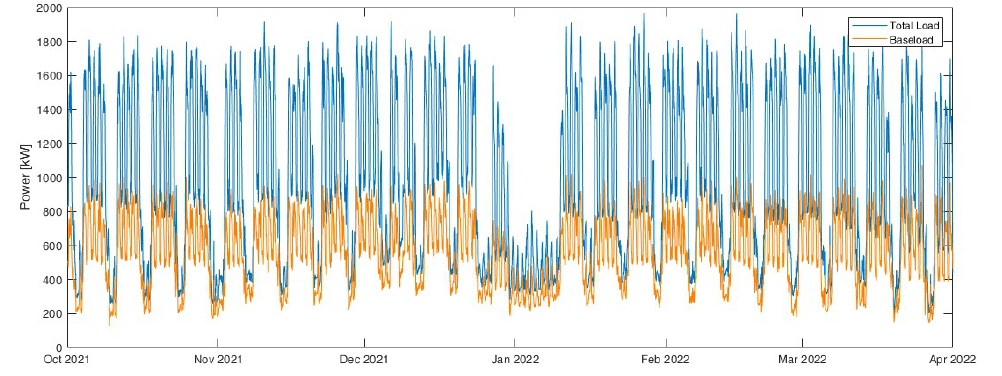
Figure 7. Computed baseload (in orange) compared with the total load (in blue).